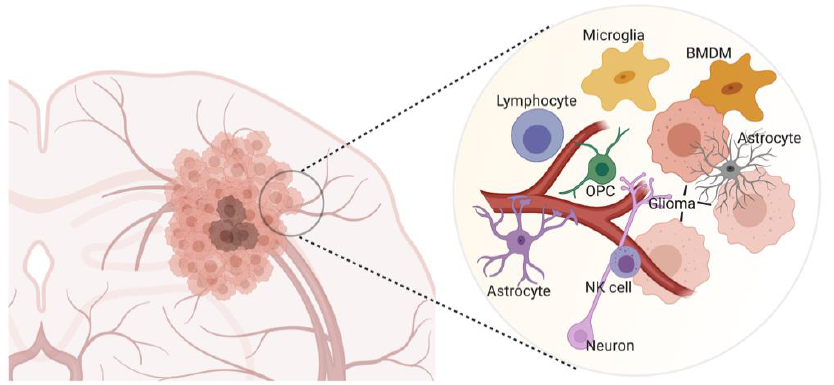
Figure 1. Overview of the glioma microenvironment. The brain TME includes microglia, bone marrow-derived macrophages (BMDM), astrocytes, oligodendrocyte precursors (OPC), neurons, lymphocytes, and natural killer (NK) cells. NK, natural killer cells; OPC, oligodendrocyte precursors; BMDM, bone marrow-derived macrophages. The figure was created with BioRender.com (accessed on 12 March 2021) and was exported under a paid subscription.